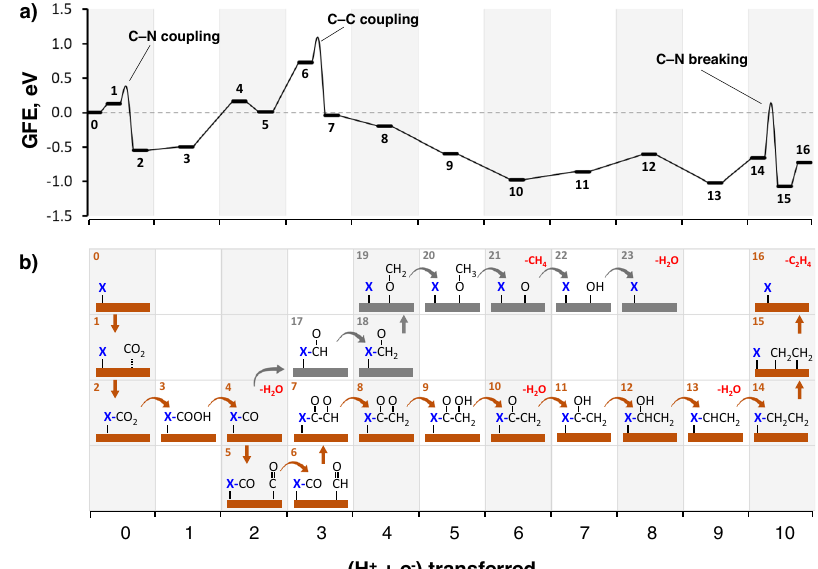
b Reaction pathways for the histidine-assisted electroreduction of CO 2 to CH 4 and C 2 H 4 on Cu(100). Histidine molecule is represented by a blue “ X ” . Note that the reaction may follow two separate pathways from (4), through either (5) towards C 2 H 4 (marked with orange substrates) or (17) towards CH 4 (marked with grey substrates). Details on the histidine-assisted formation of CH 4 are discussed in SI Section 6.7. Desorbed molecules during the chemical process are indicated in red. Thenumberatthetopleftcornerofeachboxrepresentsthereactionstepnumber as described in the main text.